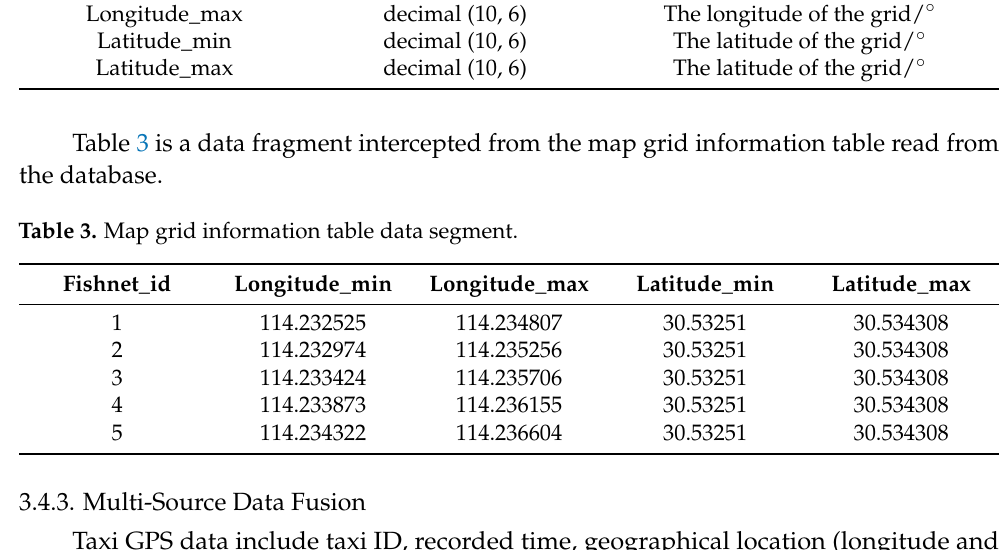
Table 3. Map grid information table data segment.